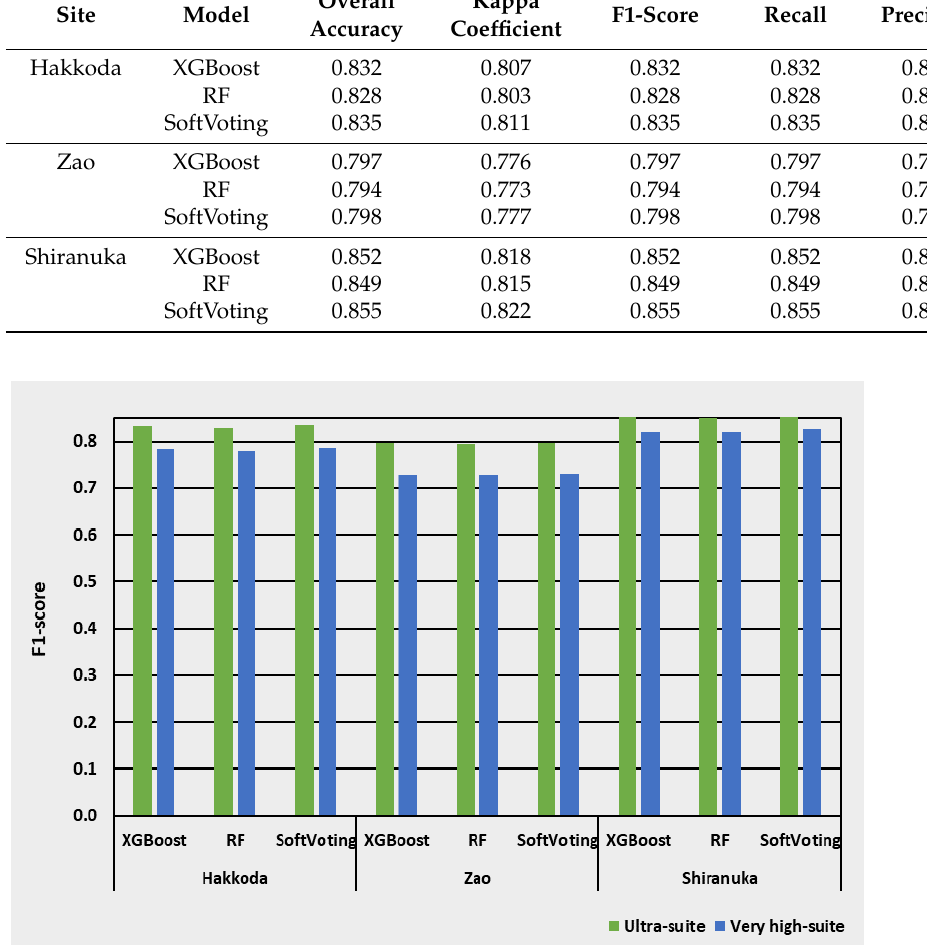
Figure 8. Accuracy variation with classifiers using bi-seasonal images.